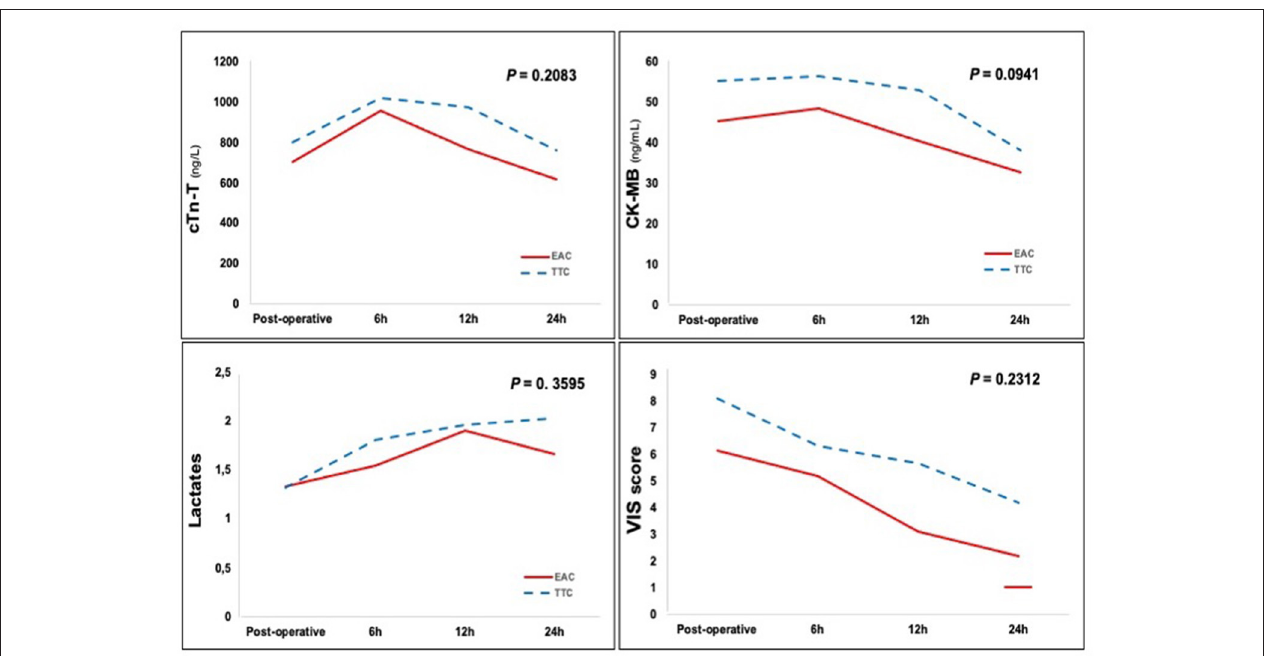
FIGURE 1 | Post-operative cTn-T and CK-MB activities, lactates levels and VIS score. EAC, endo-aortic clamp; TTC, trans-thoracic clamp; cTn-T, cardiac Troponin T; CK-MB, creatinine kinase-myocardial band; VIS, vasoactive-inotropic